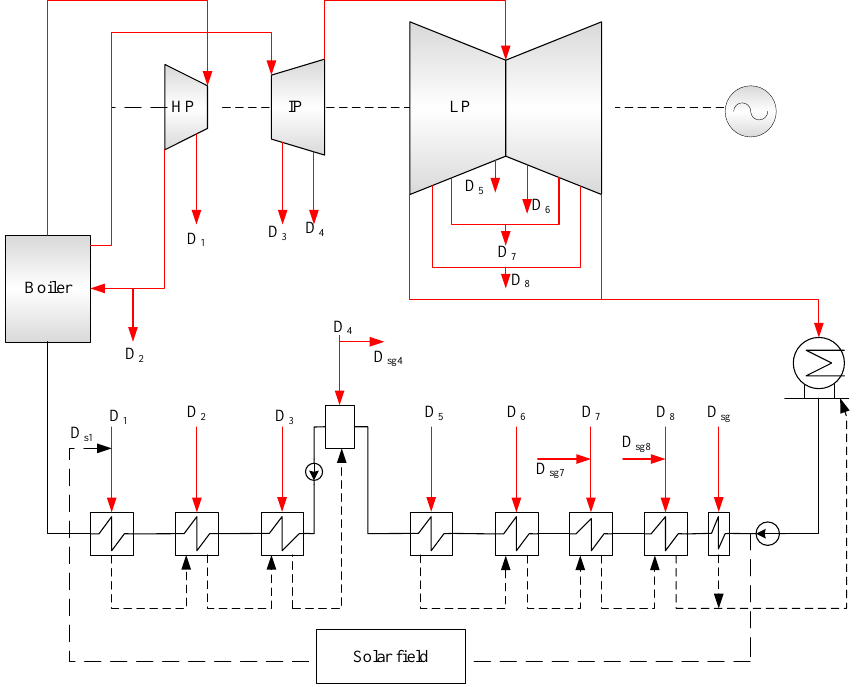
Figure 1. Solar-aided power generation (SAPG) system.